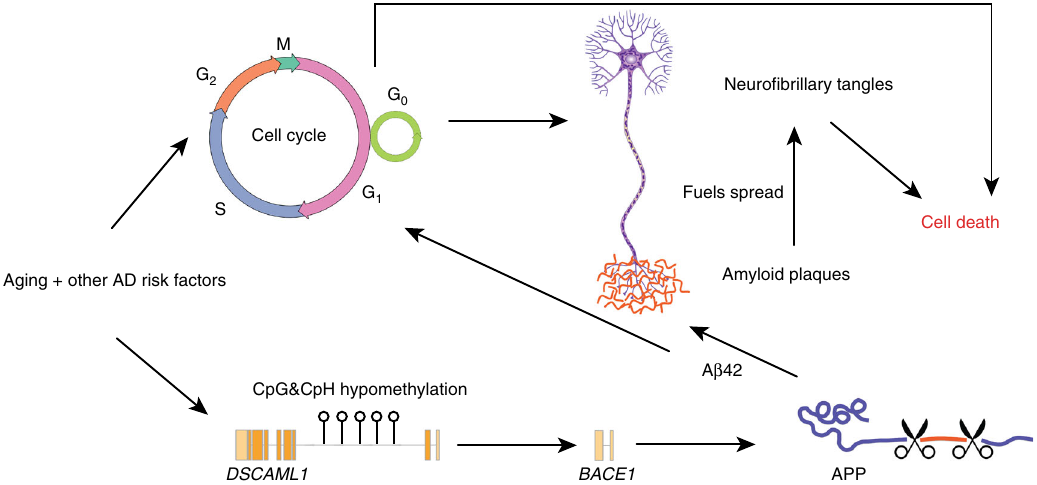
Fig. 7 Proposed model displaying the contribution of enhancer dysregulation to the development and progression of AD. In aging, neurons gradually lose CpH methylation at enhancers, especially at enhancers regulating genes involved in the early cell cycle. Aging and other AD risk factors that trigger improper attempts of neurons to renter the cell cycle promotes the formation of neuro fi brillary tangles in the AD brain and is neurotoxic. In AD neurons there is also a hypomethylation of enhancers in DSCAML1 that occurs early in disease. Enhancers in DSCAML1 activate BACE1 expression, which leads to the increased production of the A β peptides. A β peptides promotes an accelerated loss of DNA methylation at enhancers in AD neurons, thereby facilitating aberrant cell cycle reactivation. A β peptides also forms plaques, which fuels the spread of neuro fi brillary tangle pathology across the brain. Consequently, epigenetic changes at enhancers in AD neurons contributes to the pathology, neurodegeneration, and cognitive symptoms of